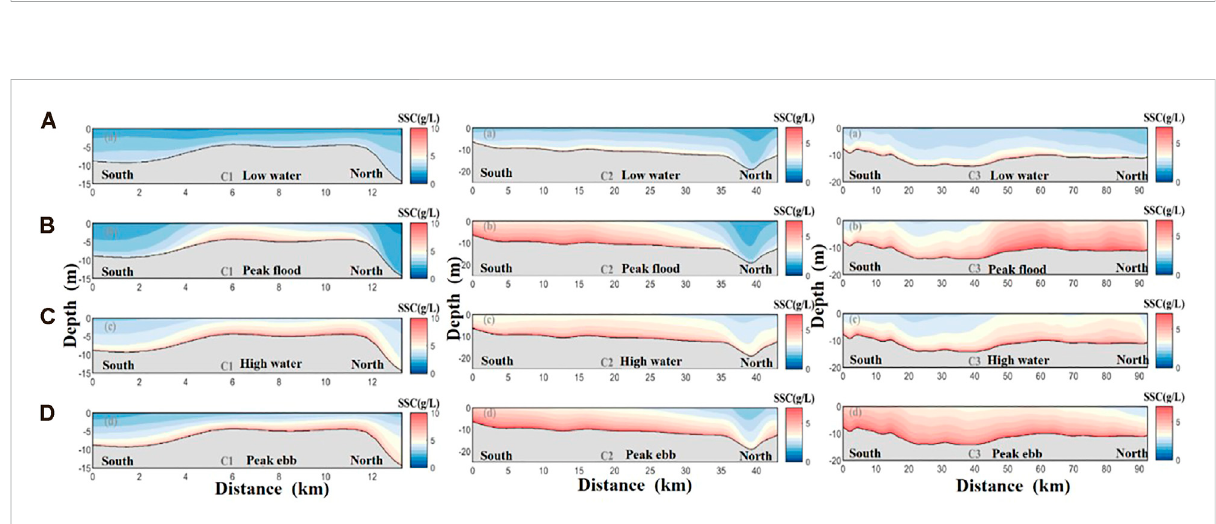
FIGURE 8 Vertical SSC distribution at C1, C2, and C3 cross-sections: (A) low water, (B) peak fl ood, (C) high water, and (D) peak ebb.